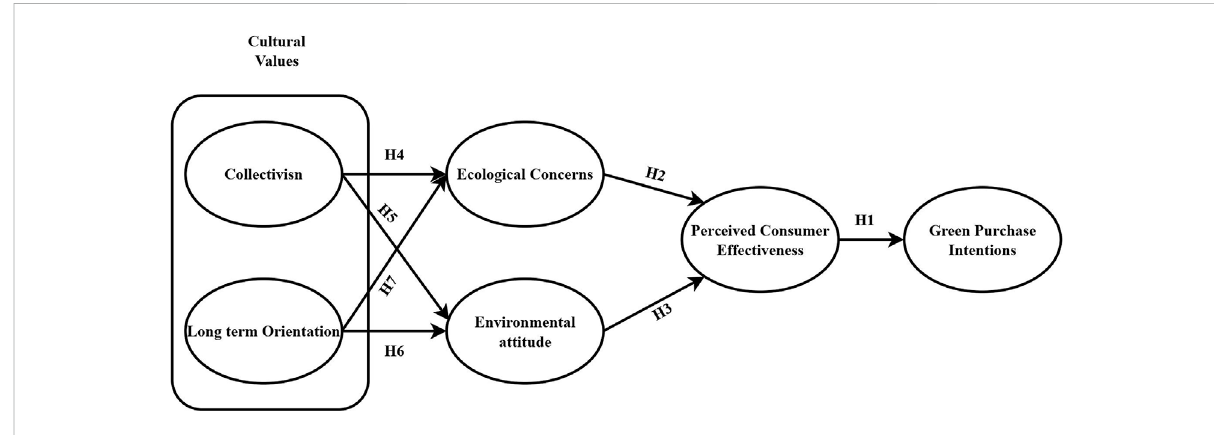
FIGURE 1 The theoretical